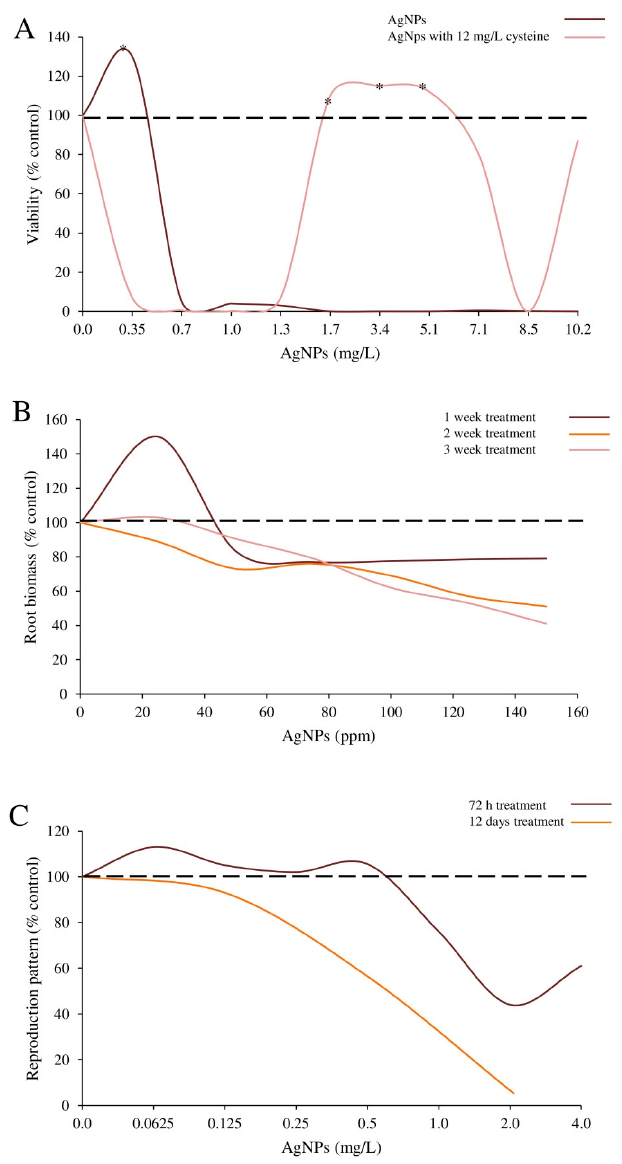
Figure 5. Influence of experimental conditions on the occurrence of hormesis. ( A ) The addiction of cysteine in culture media significantly affected the hormetic behavior of Ag-NPs (modified by Guo et al. [17]). ( B ) Duration of exposure might influence the induction of a biphasic response by Ag-NPs (modified by Razzaq et al. [31]). ( C ) The hormesis response induced by Ag-NPs in Caenorhabditis elegans is evident following a sub-acute period of exposure, while after 12 days it was no longer observable (modified by Tyne et al. [33]). * Indicates statistical significance ( p < 0.05).